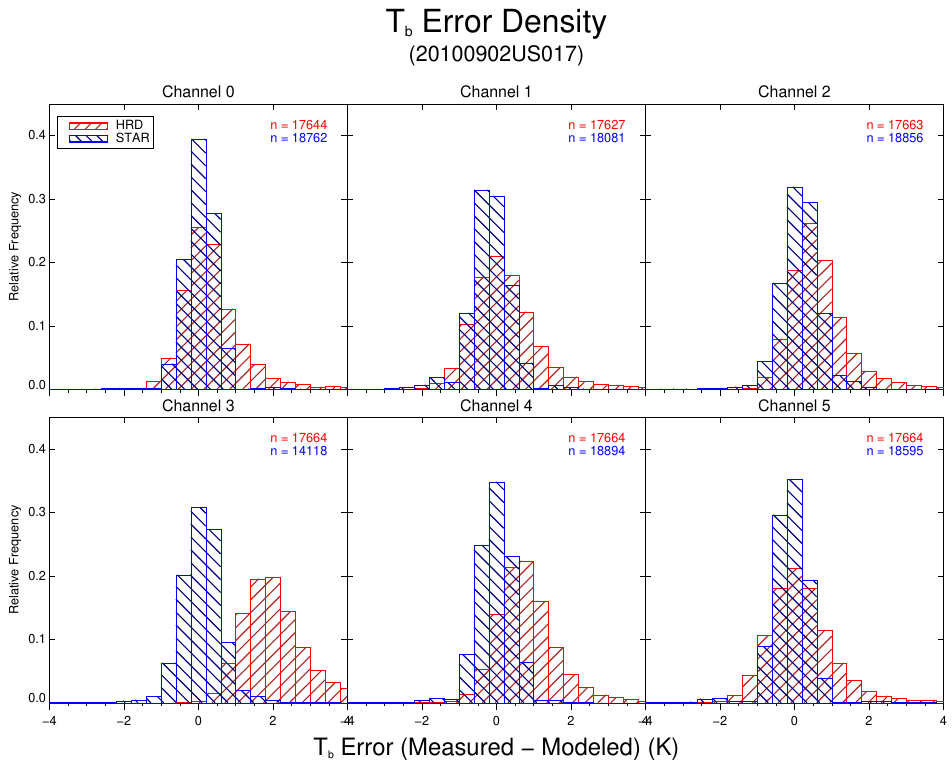
Figure A1. T b tuning error by channel for the 20100902US017 AFRC flight. Numbers in the upper right corner correspond to number of data points contained in each histogram. There are differences due to different flagging and filtering criteria for each source (HRD or STAR) and for each